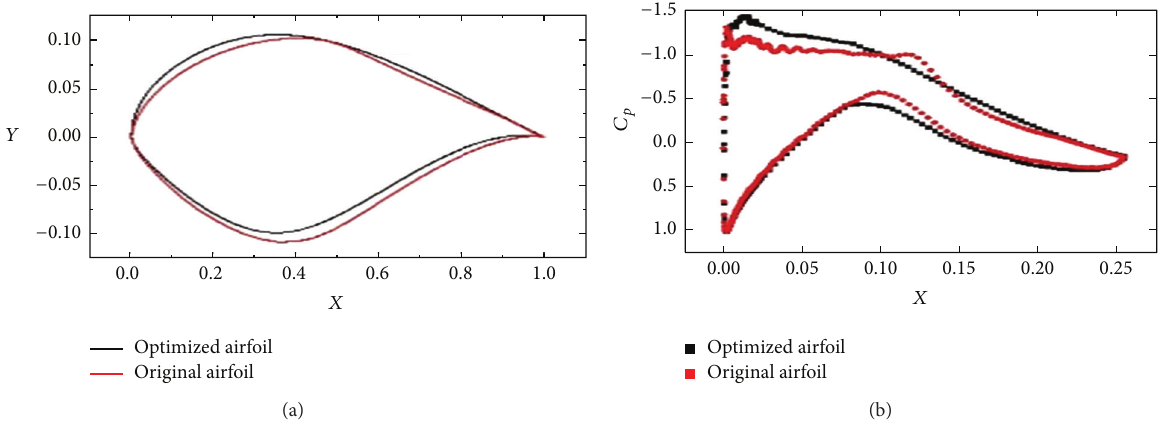
Figure 11: Comparison of original airfoil and optimized airfoil (23% span): (a) shape and (b) pressure